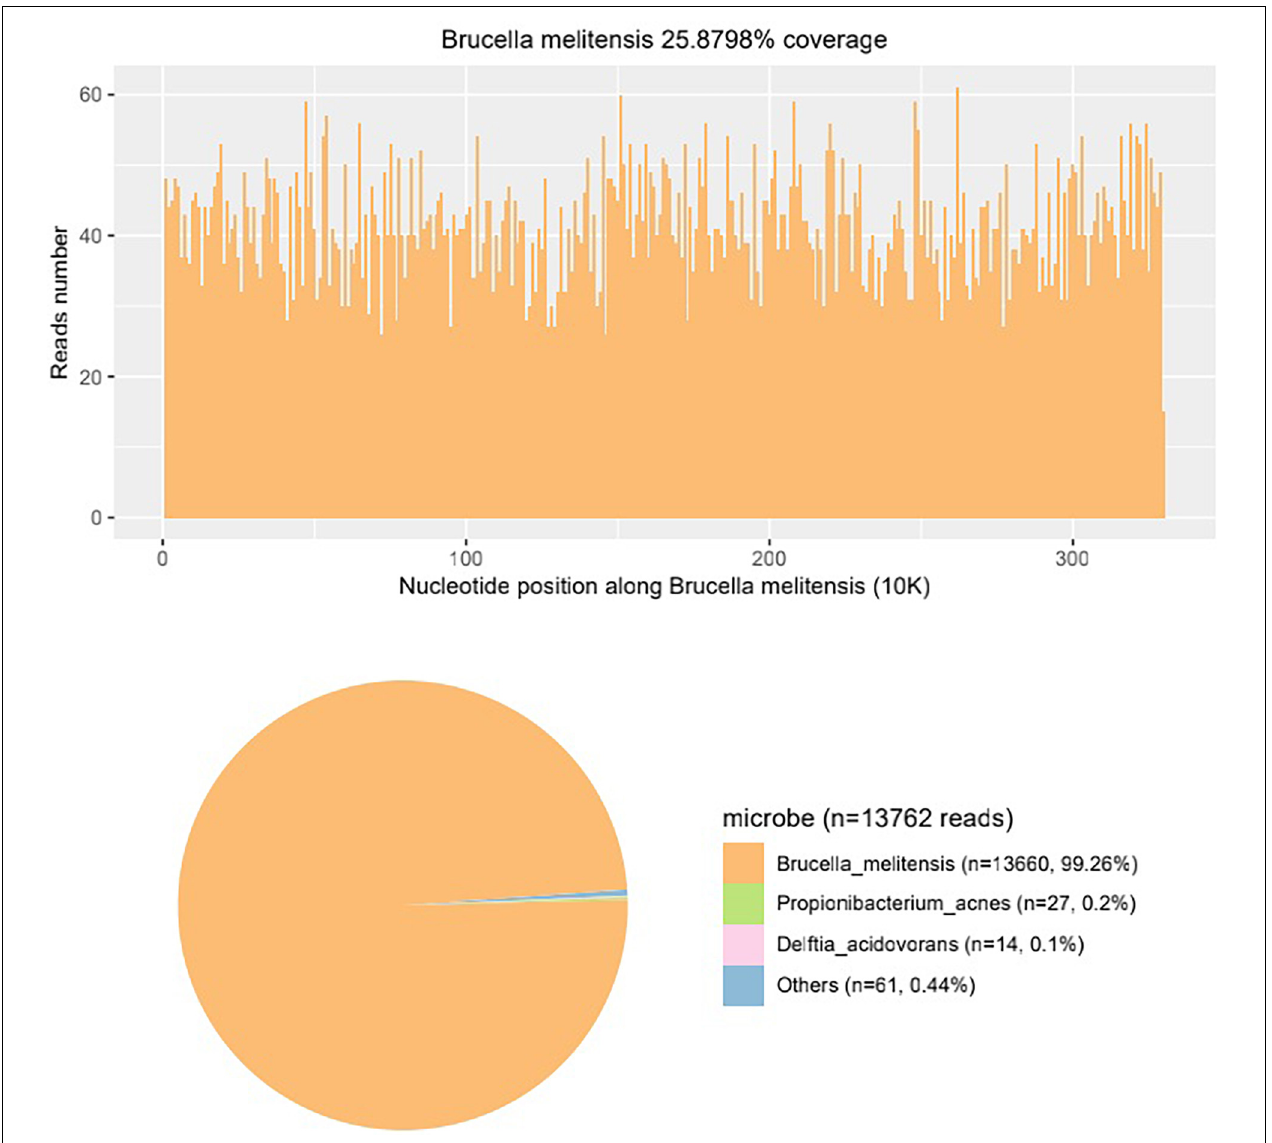
FIGURE 3 | The mNGS result of the aqueous humor shows Brucella melitensis nucleotide reads account for the vast majority, identifying that the pathogen of the patient is Brucella melitensis